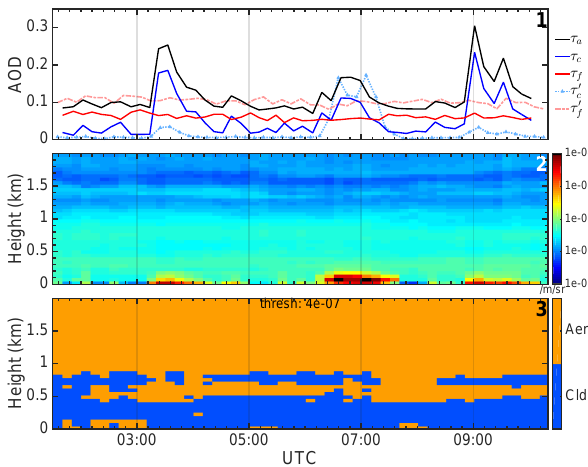
Figure 7. An altitude and temporal zoom of Fig. 4 for 10 March 2011. The CRL profiles are shown for the lowest 2km.